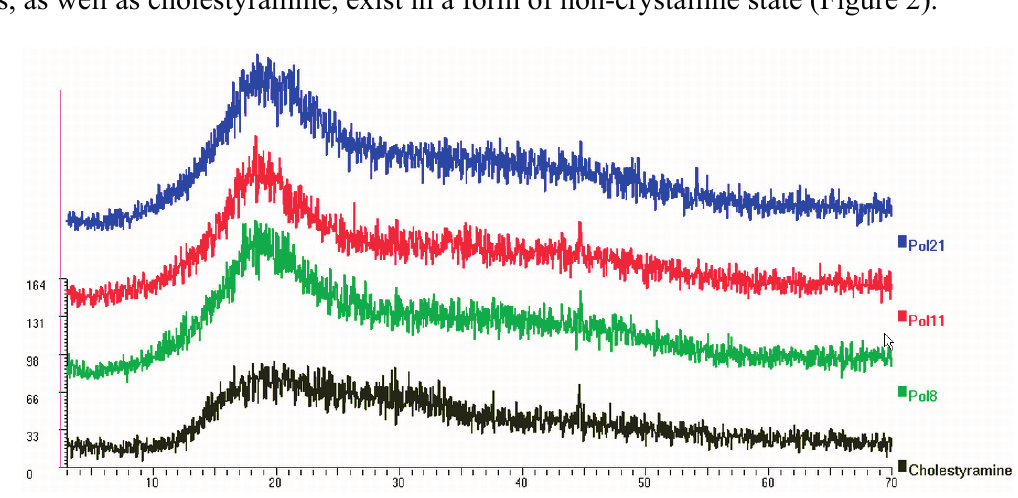
Figure 2. X-ray diffraction patterns of the polymers selected [ 8 (l-CS), 11 (l-CX) and 21 (l-S_BPY); l = low DVS:saccharide stoichiometry, C = β -CD, X = dextrin, = starch; BPY = bis(2-hydroxyethyl)amine] for animal